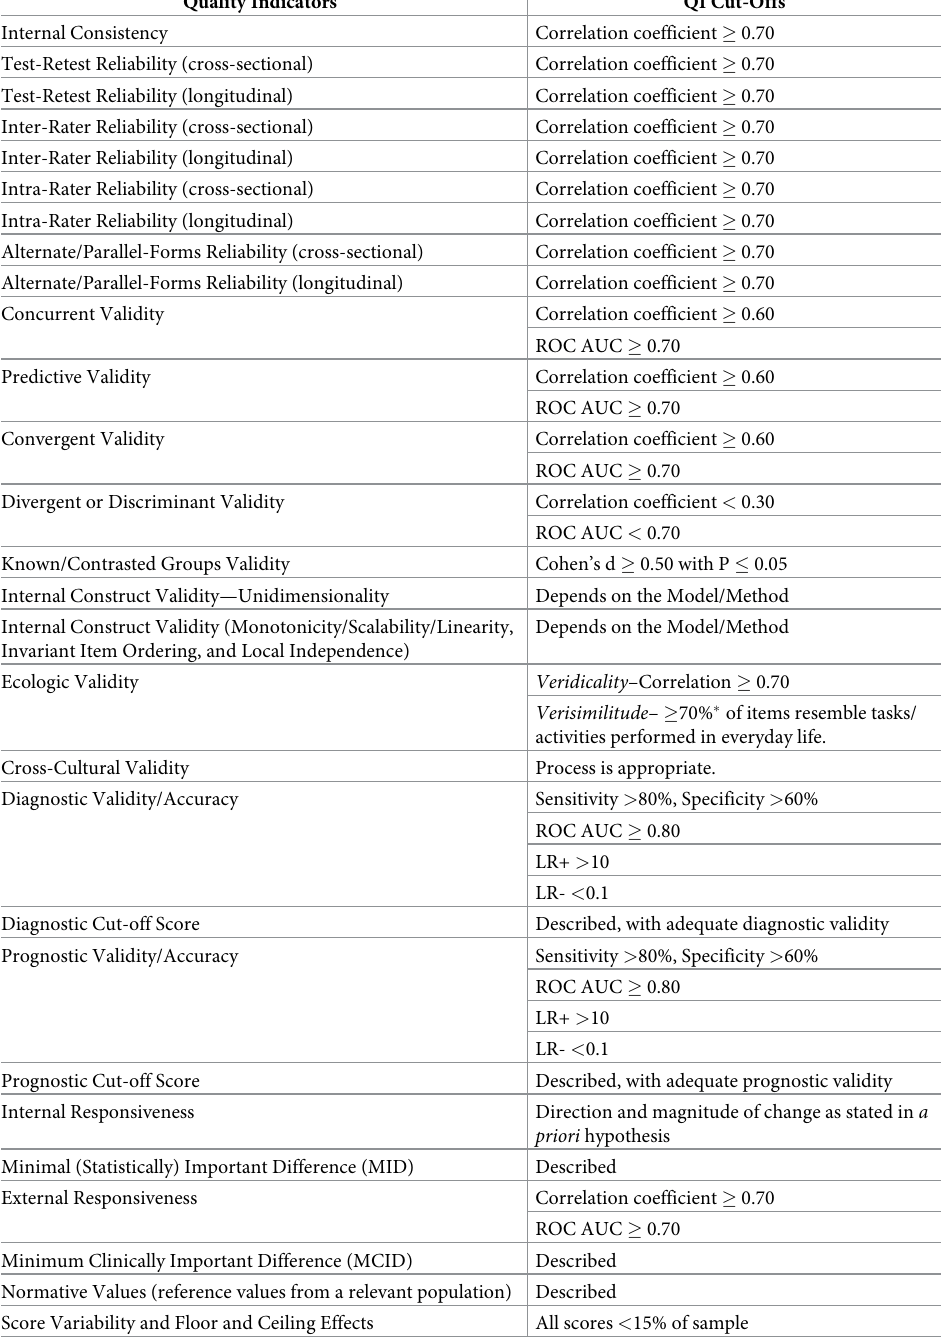
Table 2. Quality indicators for grading and development of recommendations for